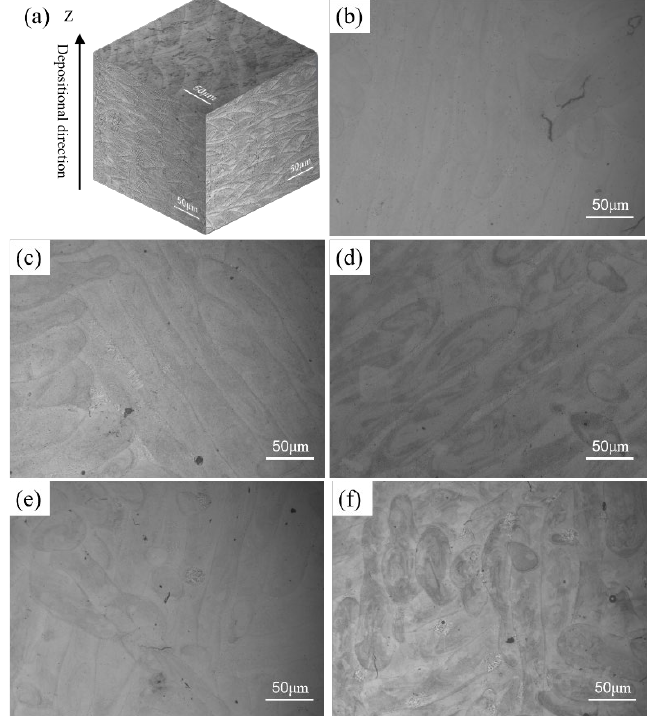
Figure 3. ( a ) The 3D metallographic diagram of k418, and ( b – f ) the transverse section metallography corresponding to different laser powers (( b ) 800 mm/s; ( c ) 1000 mm/s; ( d ) 1200 mm/s; ( e ) 1400 mm/s; ( f ) 1600